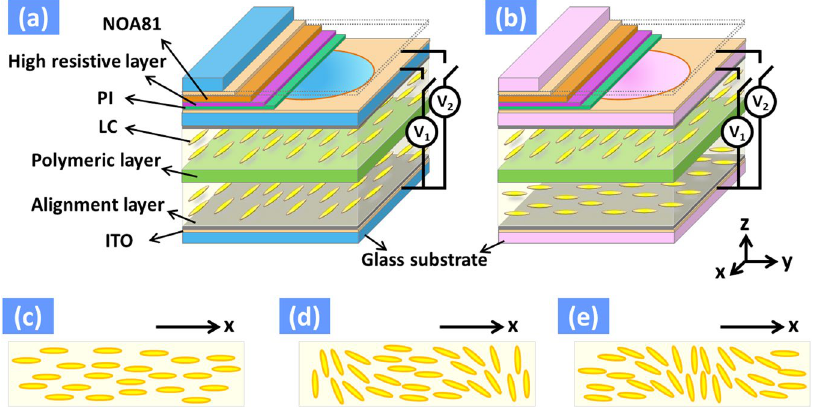
Figure 2. The structure of ( a ) “LC lens 1” in Fig. 1(a) and (b) “LC lens 2” in Fig. 1(a). A top LC layer of ( a ) and ( b ) at ( c ) V 1 = V 2 = 0, ( d ) V 1 > V 2 , and ( e ) V 1 < V 2 . The bottom LC layer of ( a ) is identical to top LC layer and the bottom LC layer of ( b ) is orthogonal in orientations to the top LC